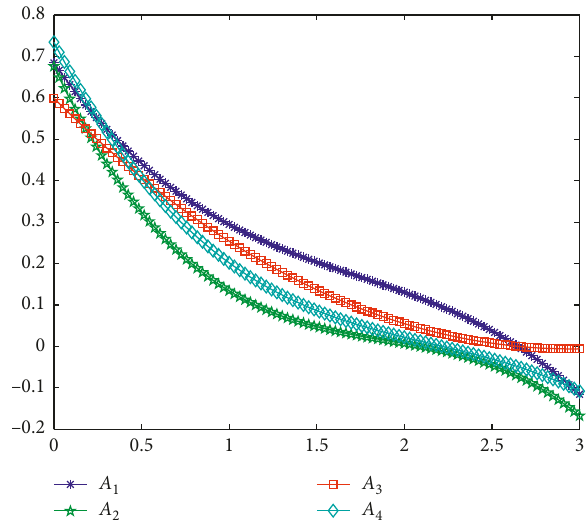
Figure 10: Variation of SC ( F operator ( p � 1 , q ∈ ( 0 , 3 ) ).